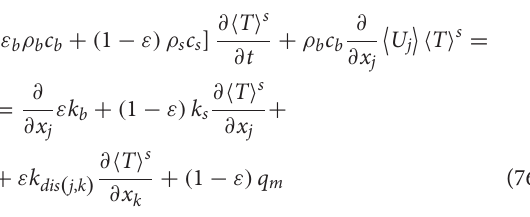
where ω Pennes is the mean blood perfusion rate; T a 0 is